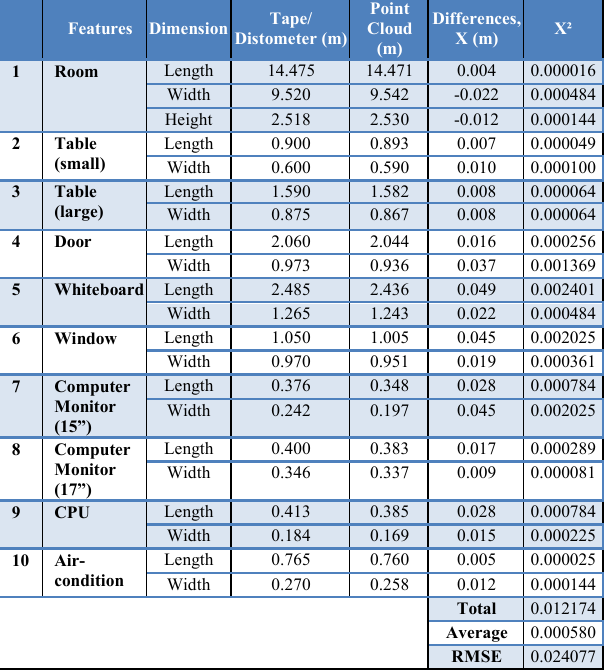
Table 2. Comparison of measurement between conventional method and point cloud